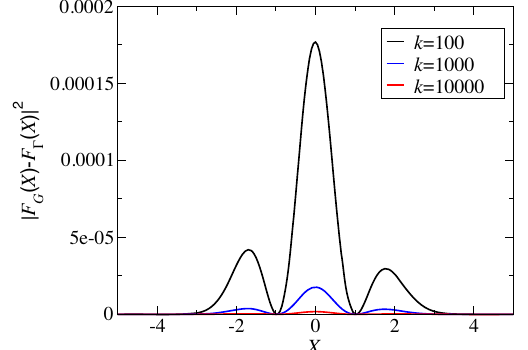
FIG. 8. Integrand of Eq. (A1) versus X for select values of the shape parameter k